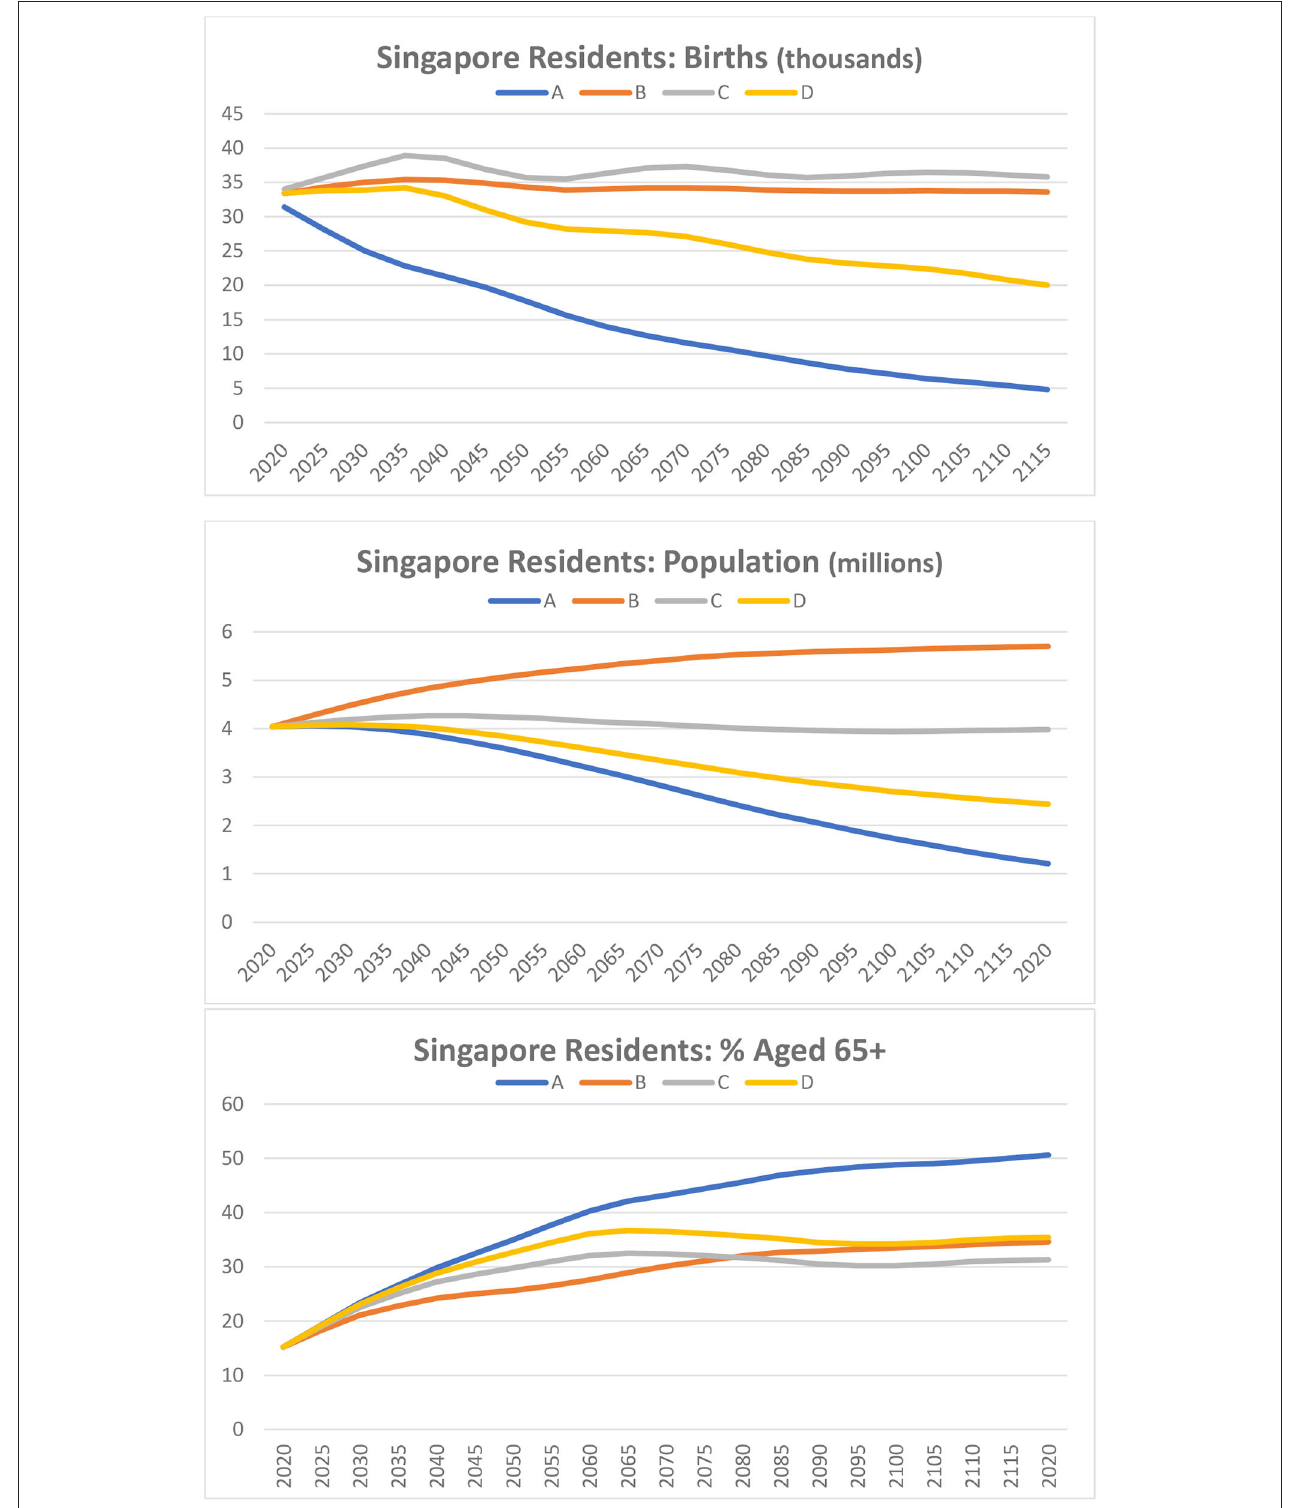
FIGURE 7 | Singapore: Projections of births, population and percent of population aged 65 + . A: TFR = 1.1; Net migration = 0. B: TFR = 1.1; Net migration = 40,000 from 2020. C: TFR rises from 1.1 to 1.7 by 2040; Net migration = 10,000 from 2020. D: TFR rises from 1.1 to 1.7 by 2040; Net migration = 0.